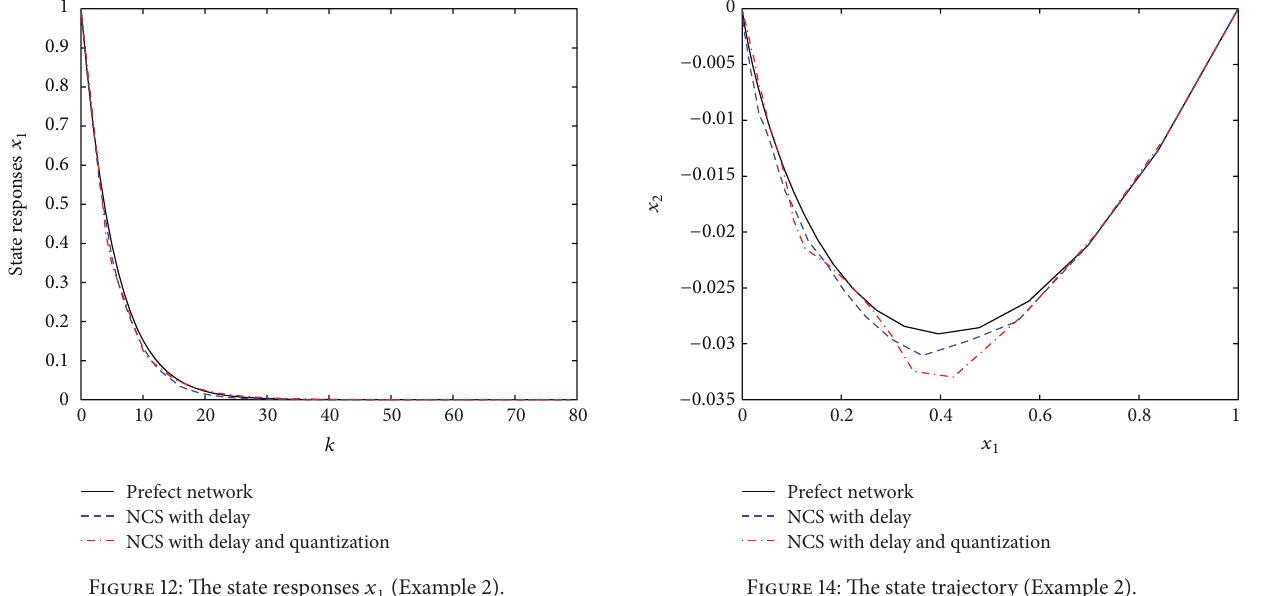
Figure 14: The state trajectory (Example 2).